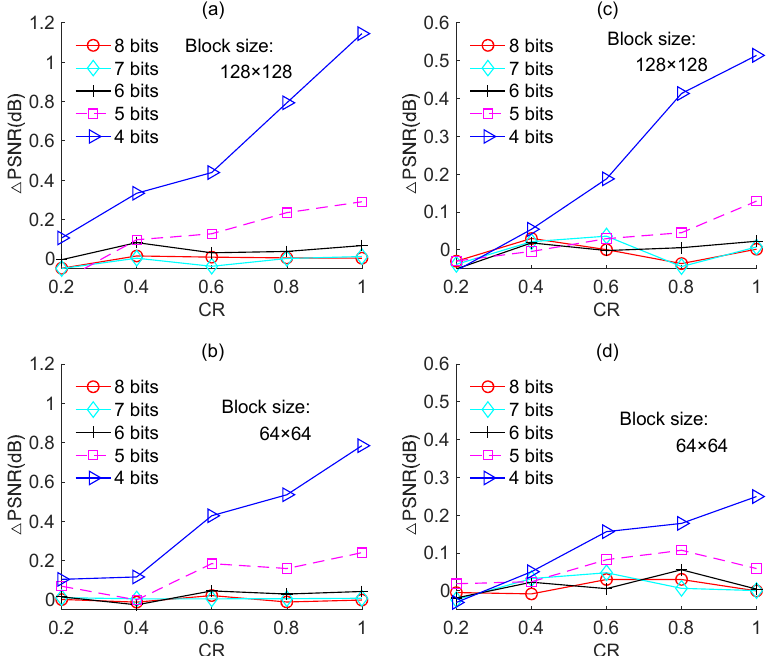
Figure 10. PSNR losses of the quantized BCS with different resolutions of ADC for the “Cameraman” image. ( a , b ) are based on Zadoff–Chu measurement matrix; ( c , d ) are based on real-valued Hadamard measurement matrix.